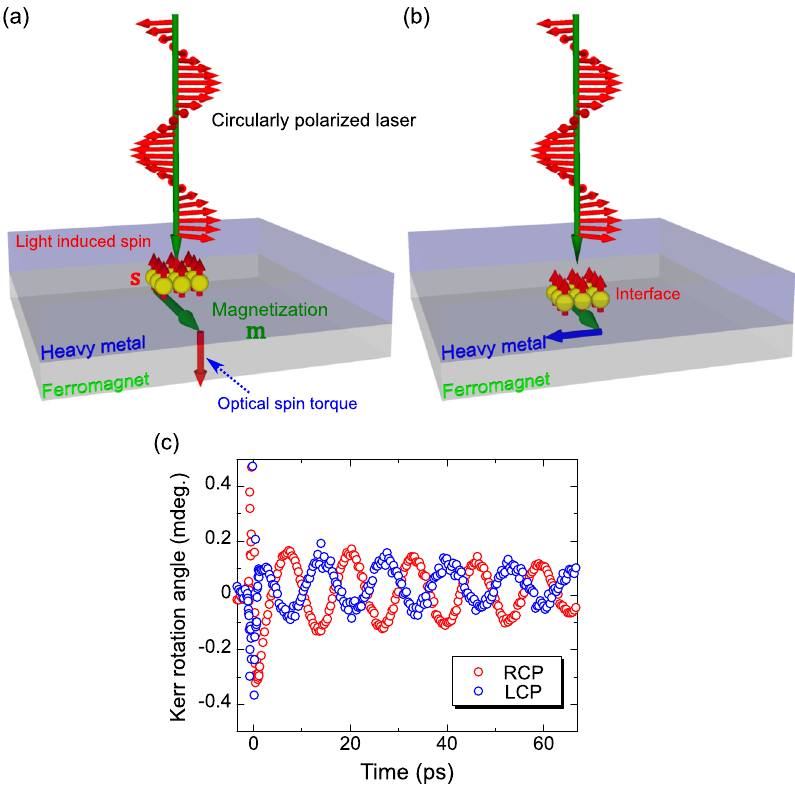
Figure 1: (a) Schematic illustration of optical spin torque induced by the optical orientation in the heavy metal layer. (b) Field-likeopticalspintorqueinducedbythe circularly polarized laser due to interface spin – orbit coupling. (c) Typical magneti- zation precessional dynamics excited by circularly polarized laser pulse with different optical helicity for 2-nm-thick FeCo/3-nm-thick Pt thin